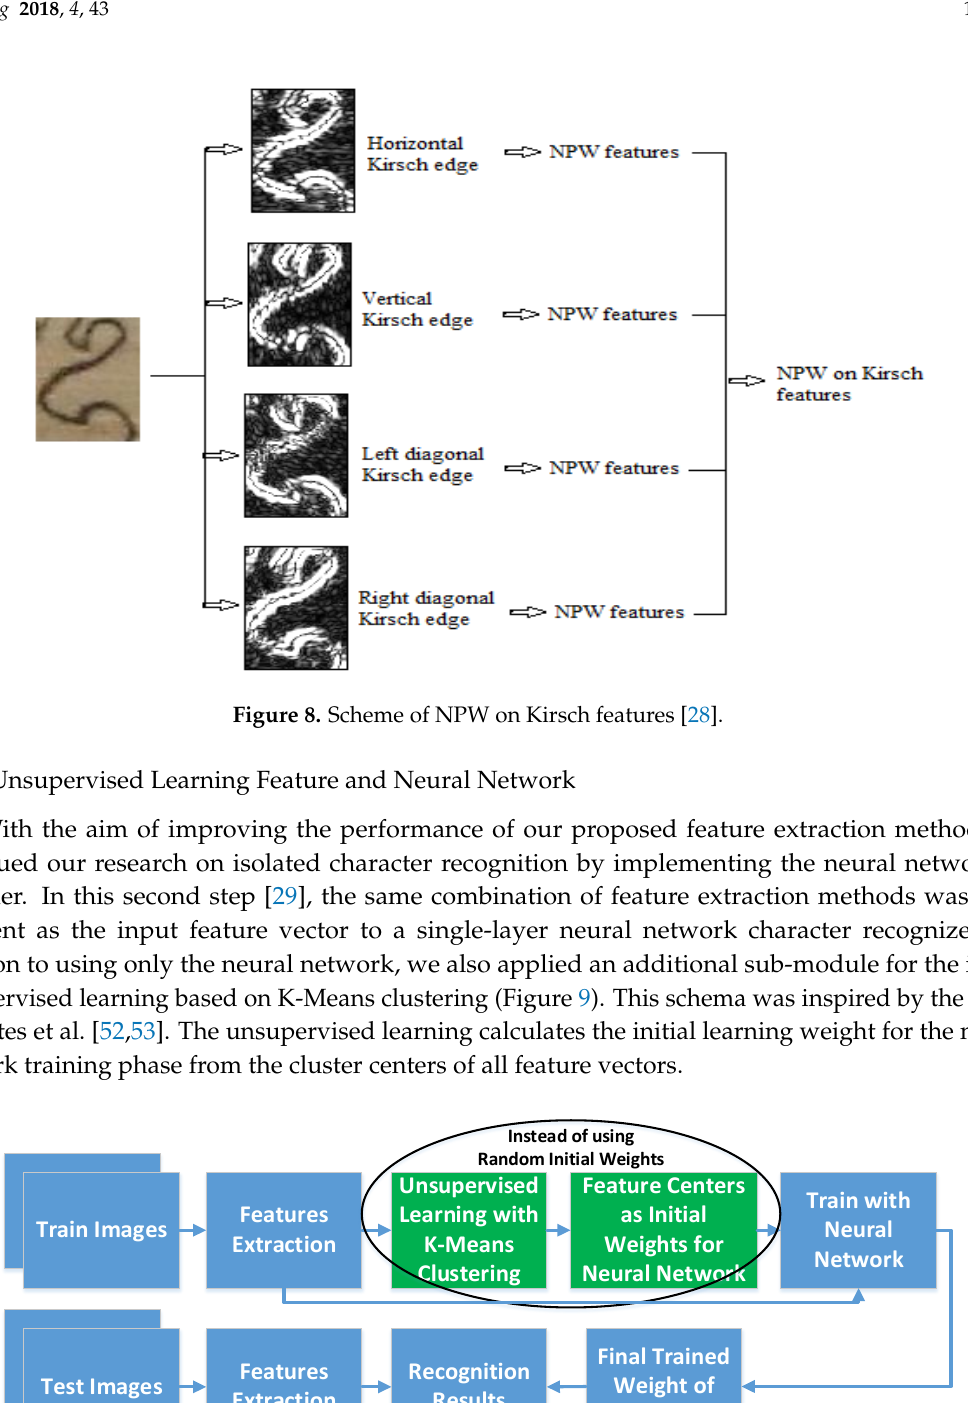
Figure 7. Type of Zoning (from left to right: vertical, horizontal, block, diagonal, circular, and radial zoning) [28].